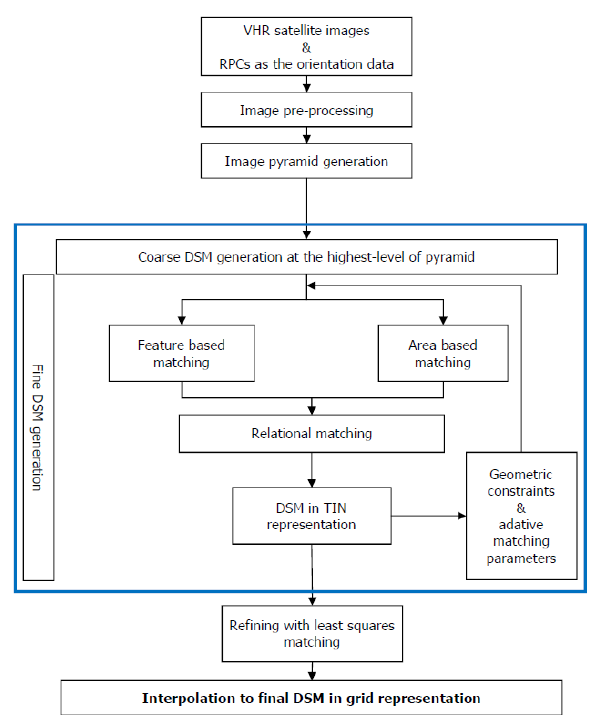
Figure 5. Workflow of the automated DSM generation in the FORSAT software